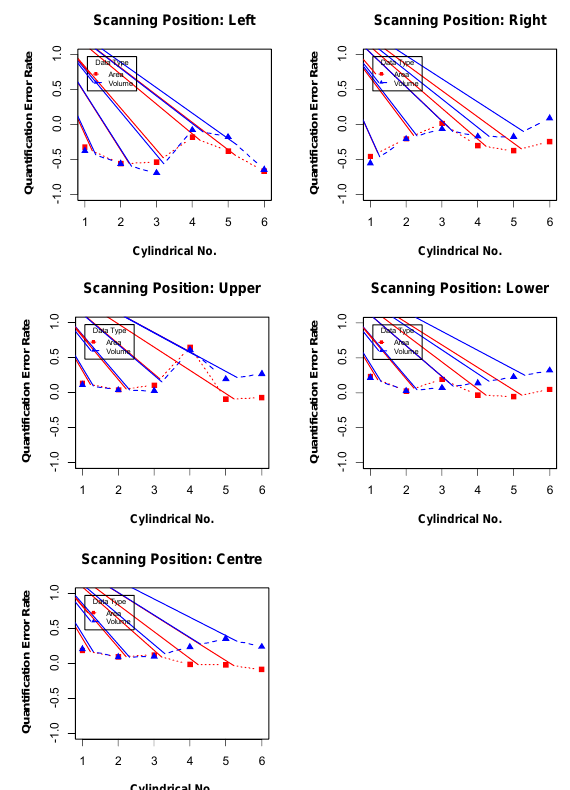
Figure 5. Comparisons of defect quantification error rate due to scanning angle variance